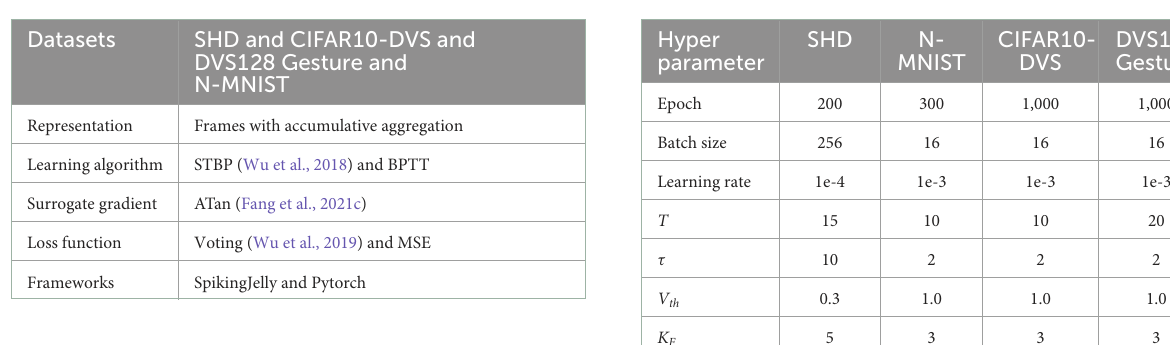
TABLE 1 Experimental details. TABLE 2 Hyper-parameter setting.